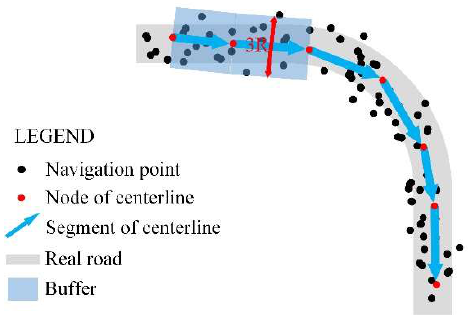
Figure 4. Centerline duplication avoidance and improvement.